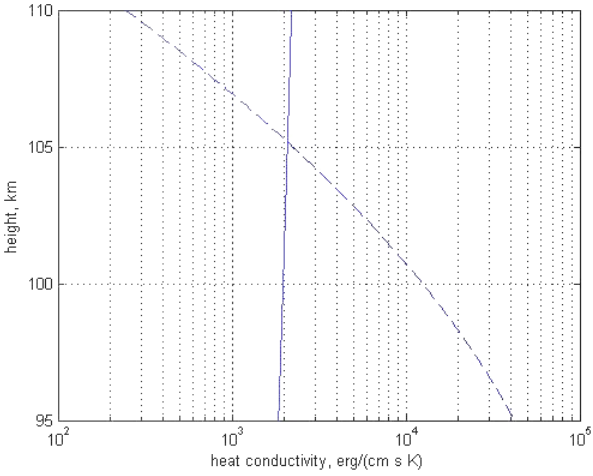
Fig. 8. Temperature height profiles in winter (dashed curve) and summer solstices (solid curve) at middle latitudes, at the equator (dashed-dotted curve), and at high latitudes (dotted curve), as given by the MSIS-E-90